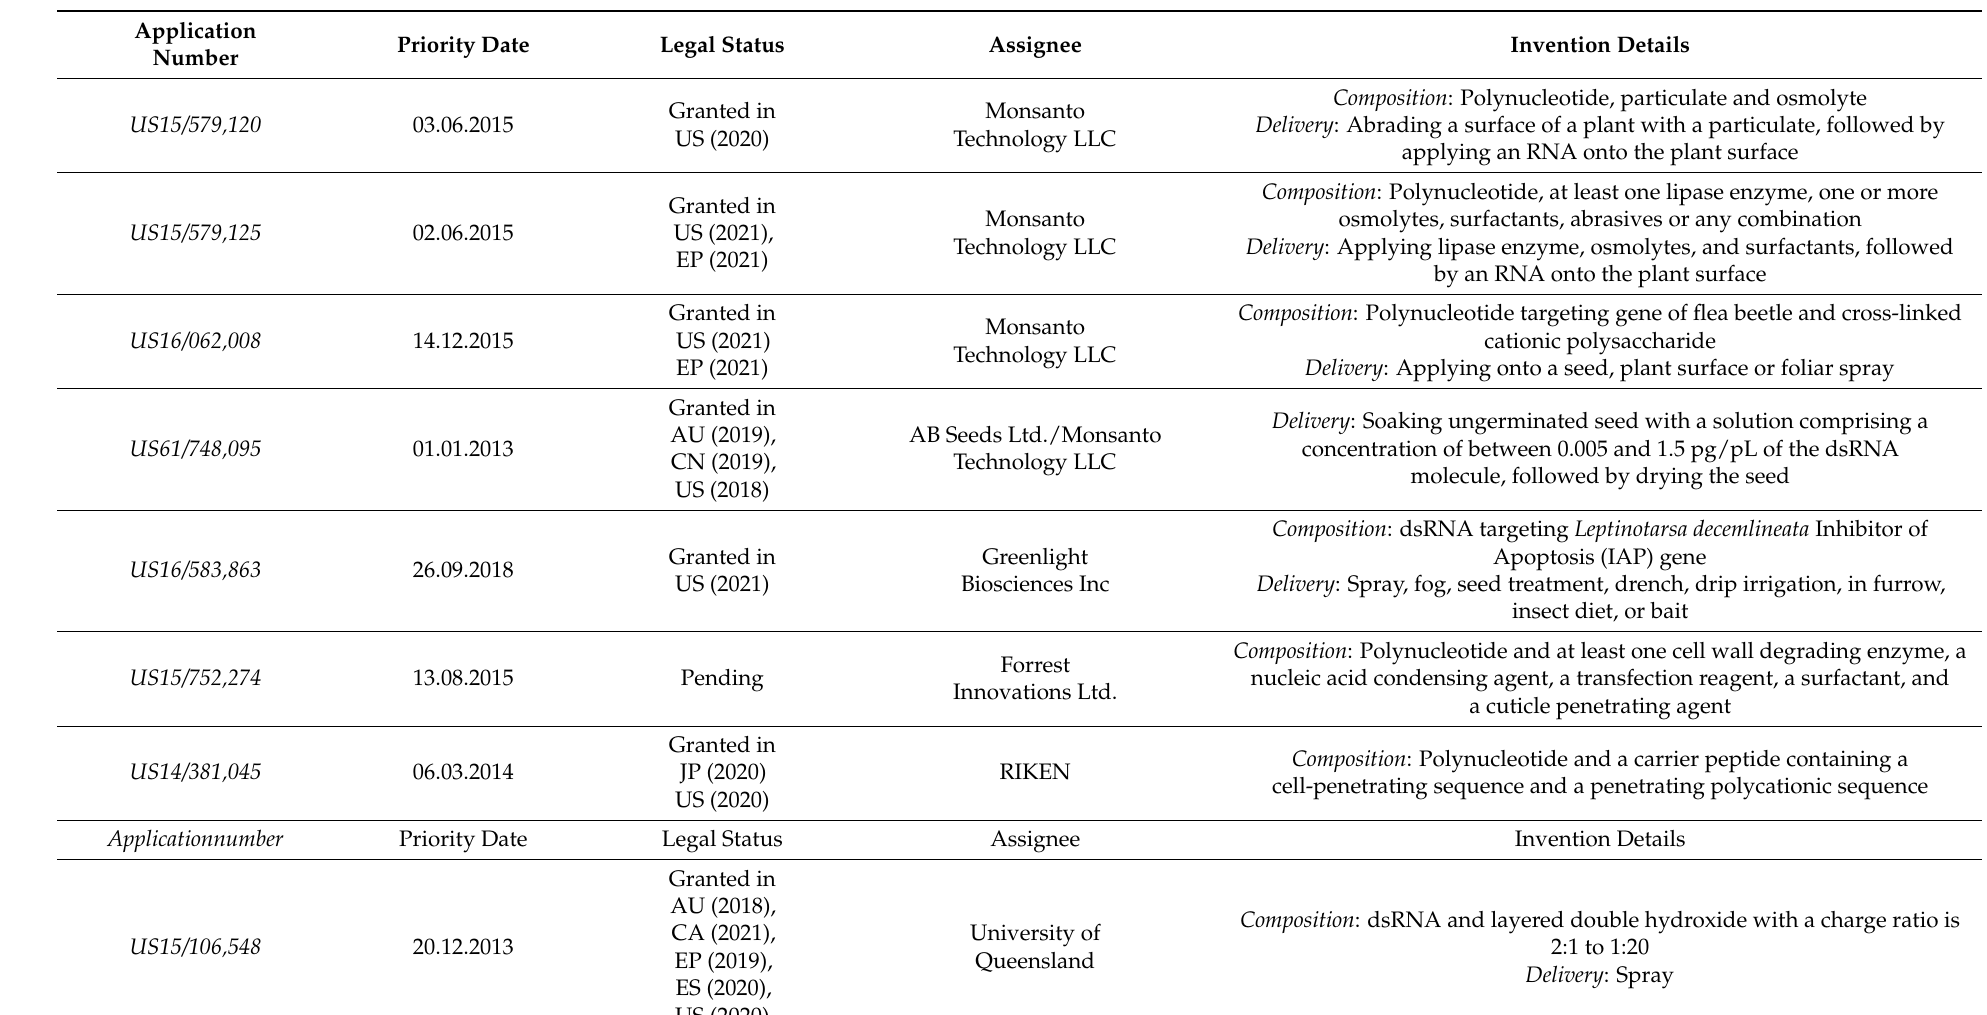
Table 3. Patent Families on Methods of Delivery and Compositions to Introduce Exogenous dsRNAs into Plant